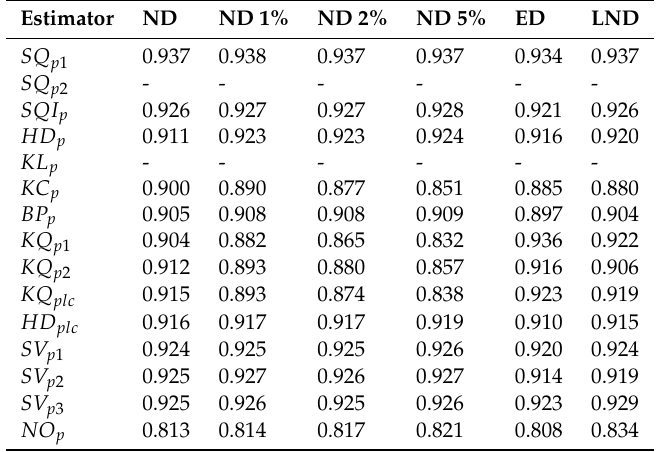
Table 1. Coverage probabilities for nonparametric Limits of Agreement ( n = 30). Neither SQ p 2 nor KL p are defined for n <